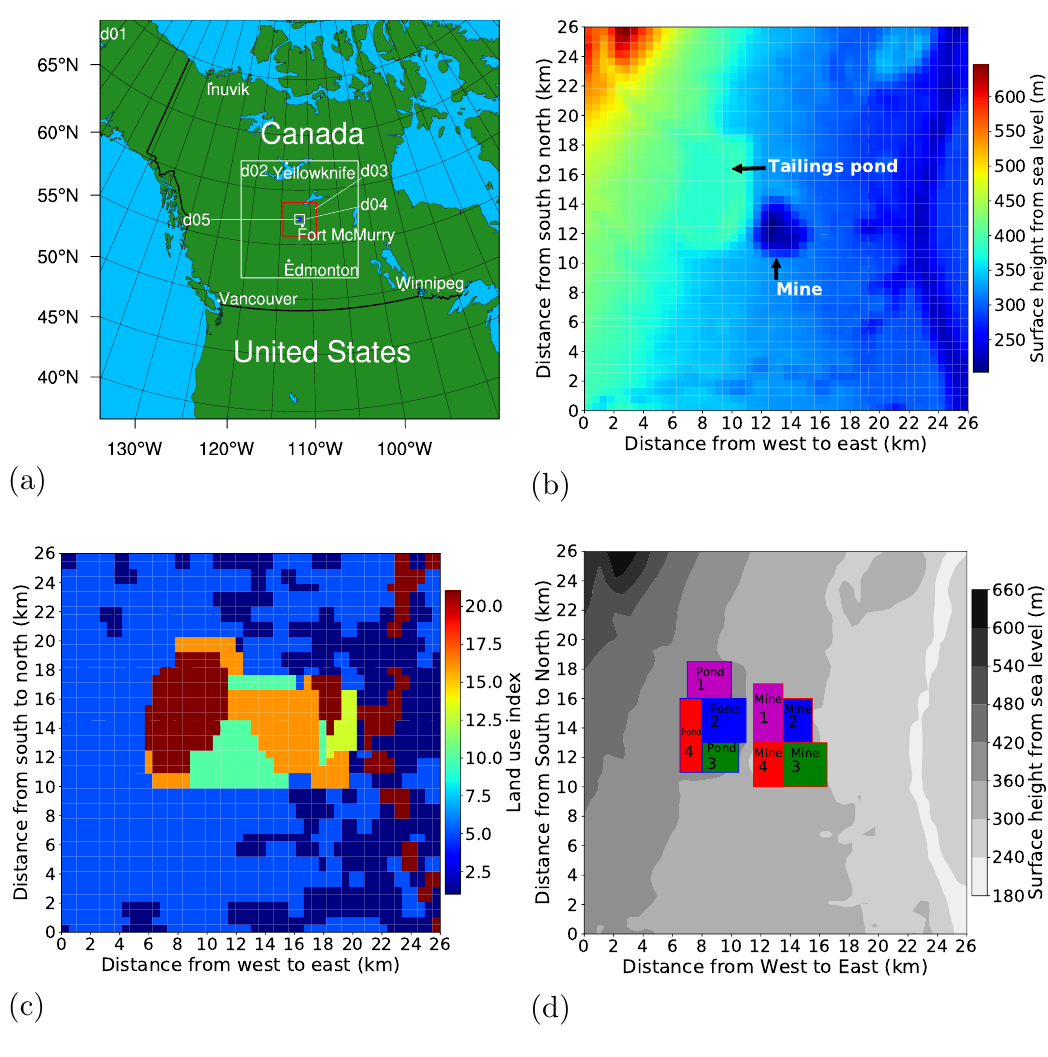
Figure 1. ( a ) Weather Research and Forecasting (WRF) simulation domains centred at the mining facility; ( b ) surface topography in the WRF domain 05; ( c ) land-use configuration in the WRF domain 05; ( d ) areas for applying the methane tracer boundary condition in the WRF domain 05; measurement sites are approximately at the centre of each